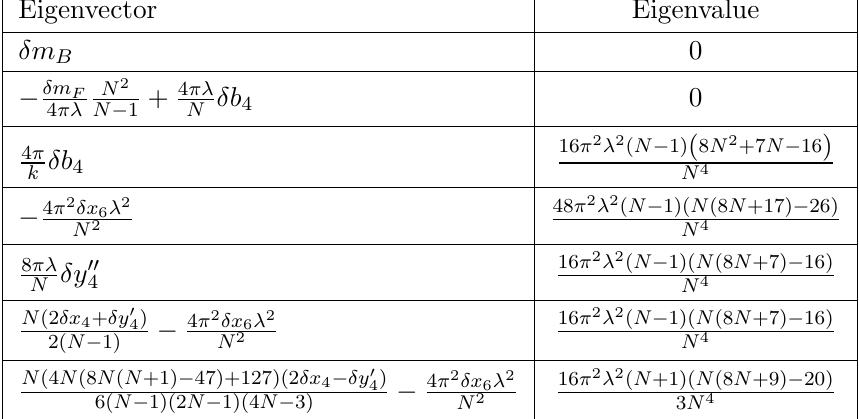
Table 1. The leading weak coupling anomalous dimensions about the mal point. The (cid:12)rst column lists the (cid:13)ow eigenvectors in the notation of (5.2), while the second column lists the eigenvalues (corrections to the classical dimensions of the corresponding